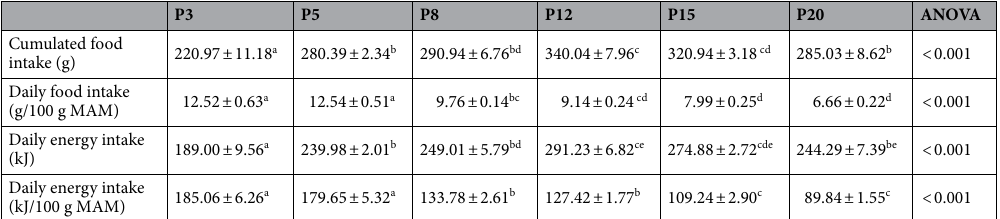
Table 1. Absolute and relative values of energy intake. Values are means ± SEM (n = 6 per group). a,b,c,d Data that do not share the same letter are different at the P < 0.05 level.